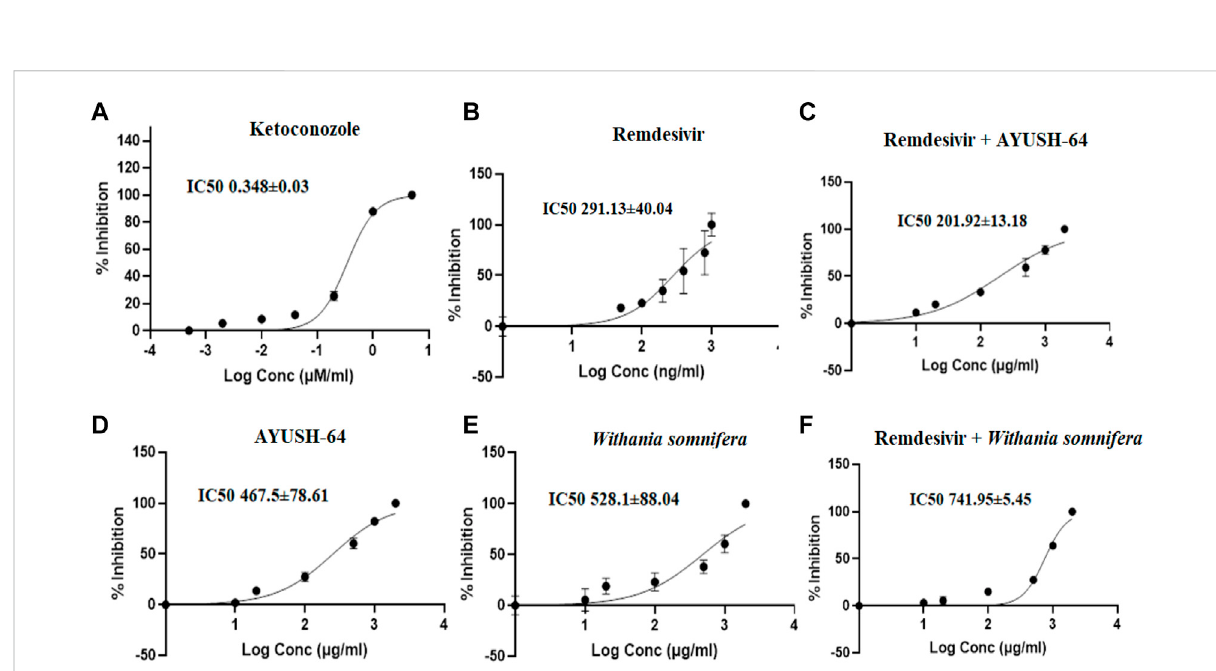
FIGURE 5 Effect of (A) ketoconazole (5.00 – 0.0005 μ M/ml), (B) remdesivir (1,000 – 1 ng/ml), (C) remdesivir + AYUSH-64 (2001 – 1.001 μ g/ml), (D) AYUSH- 64 (2000 – 1 μ g/ml), (E) Withania somnifera (2000 – 1 μ g/ml), and (F) remdesivir + Withania somnifera (2001 – 1.001 μ g/ml) on CYP3A4-mediated hydroxylation of testosterone. The graphs have been plotted for log conc. vs . percentage of